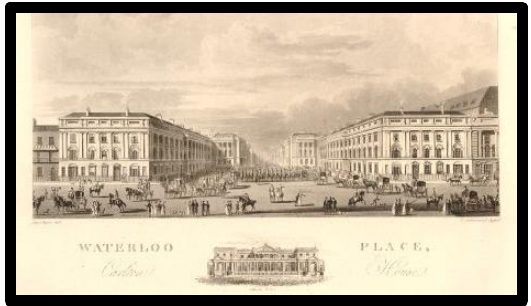
Figure 7: Sutherland T. (1817). Carlton House . (URL 4)